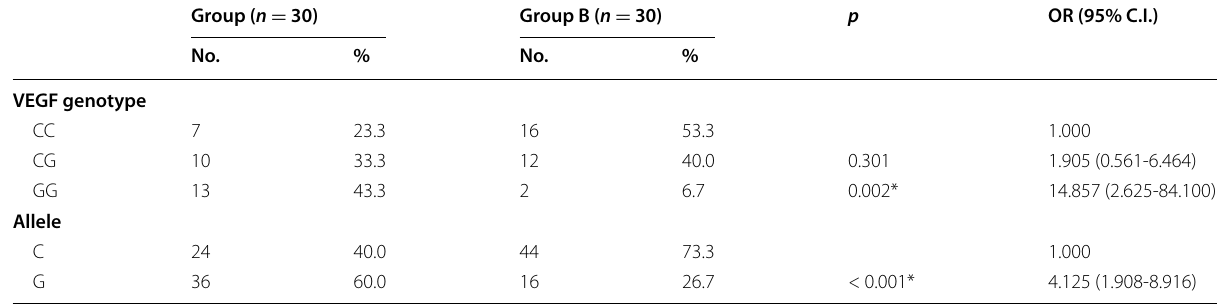
Table 4 VEGF C( 405)G (rs2010963) SNP genotype and risk for esophageal varices +